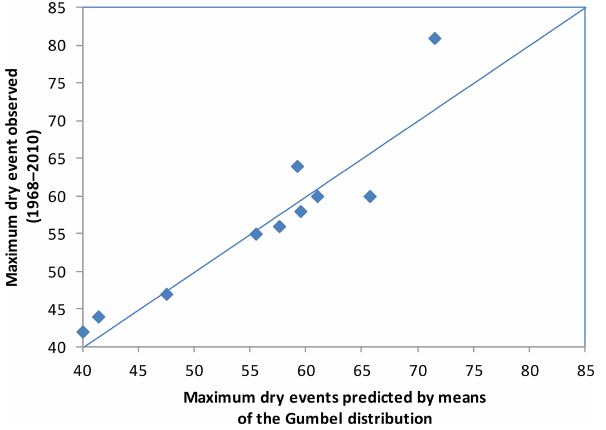
Figure 4. Differences between maximum dry events observed and estimated using AMS modelled using Gumbel distribution.